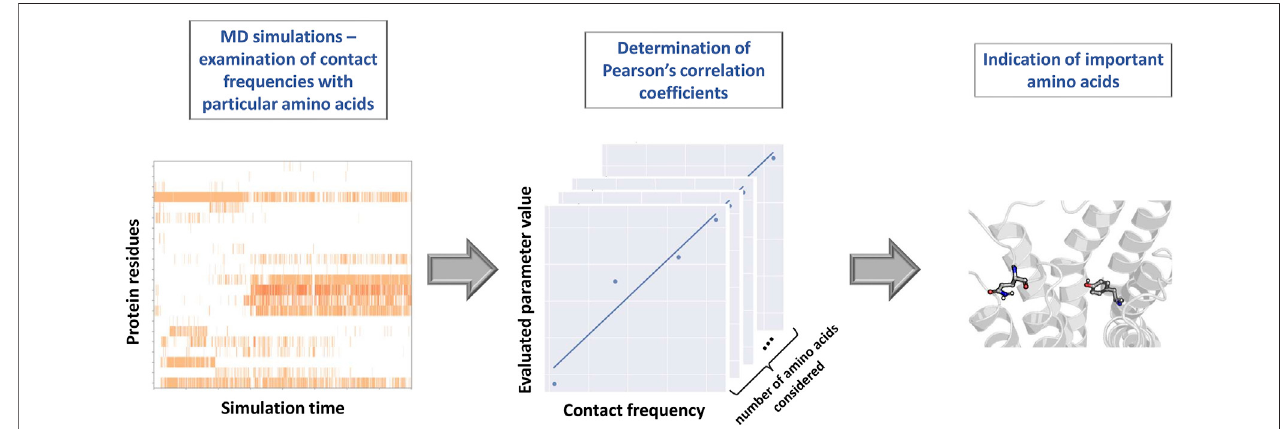
FIGURE 3 | Scheme of the protocol for indication of the important amino acids on the basis of the contact frequency with particular amino acids during MD simulations.